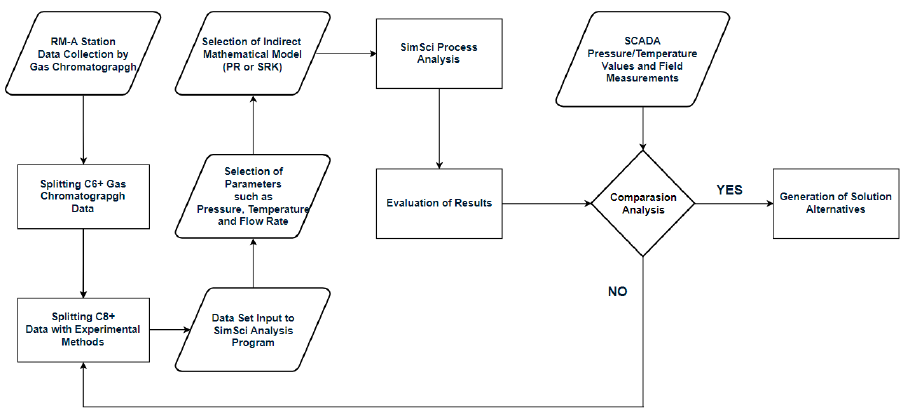
Figure 4. Natural gas liquid mass spectrometry analysis.